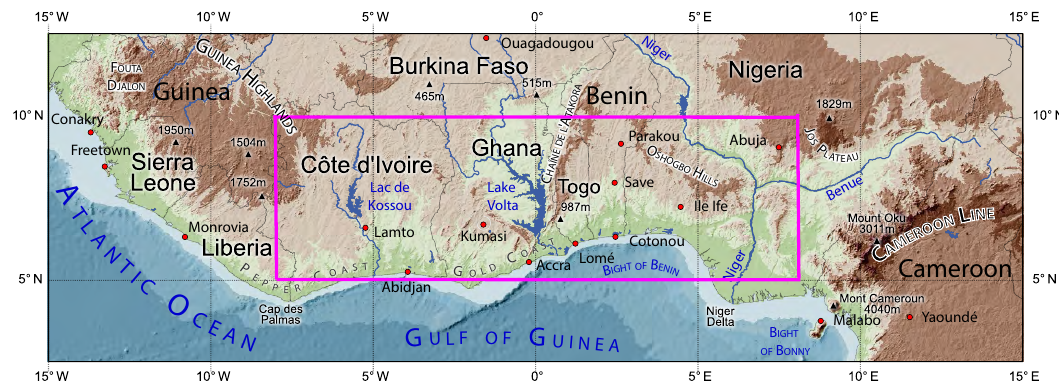
Figure 1. Geographical overview of the study region with sites and names. The purple rectangle marks the main DACCIWA focus region (5–10 ◦ N, 8 ◦ W–8 ◦